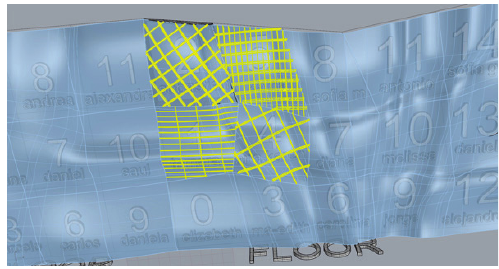
Figure 3. Design for a pre-fixed parametric system that did not fully perform as expected due to its geometrical constraints and the applied mathematical logic of the necessary intersection points